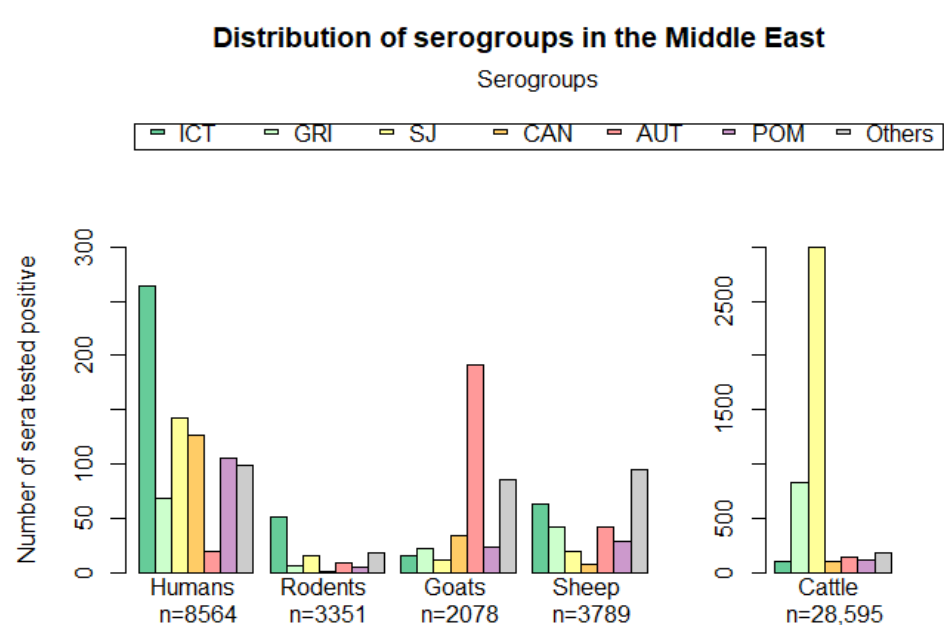
Figure 2. Distribution of serogroups in the five major hosts in the Middle East. Plot created by RStudio (RStudio Team (2021), RStudio: Integrated Development Environment for R; RStudio, PBC, Boston, MA, USA; URL http://www.rstudio.com/, accessed on 22 June 2022).